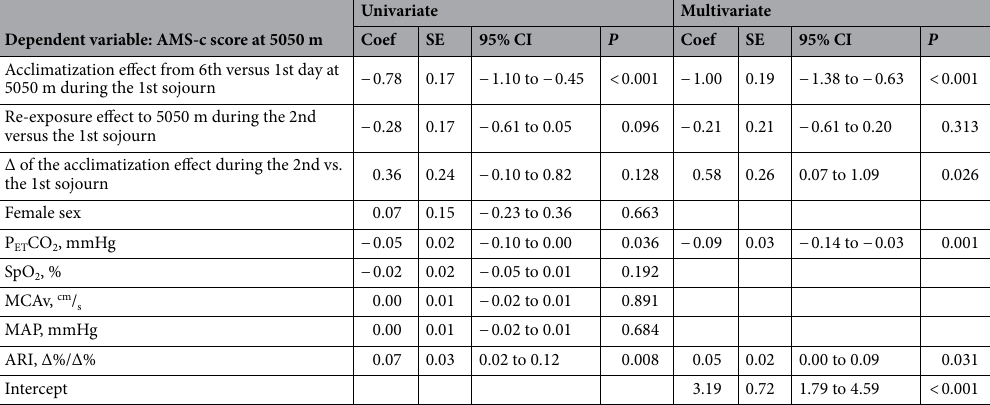
Table 3. Predictors for acute mountain sickness severity at 5050 m assessed by mixed linear regression models. N = 18 measured at 4 different time points (1st sojourn, 1st and 6th day at 5050 m; 2nd sojourn, 1st and 6th day at 5050 m). To account for the low number of observations (a total of 51 observations due to single missing values), the 5 most significant predictors from the univariate regression were entered into the multivariate regression model. Coefficients represent the change in the AMS-c score by changing one unit of the independent predictor. AMS-c score = acute mountain sickness-cerebral score, P ET CO 2 = partial pressure of end-expiratory carbon dioxide, SpO 2 = oxygen saturation measured by finger pulse oximetry, MCAv = middle cerebral artery peak velocity, MAP = mean arterial pressure, ARI = autoregulation index.